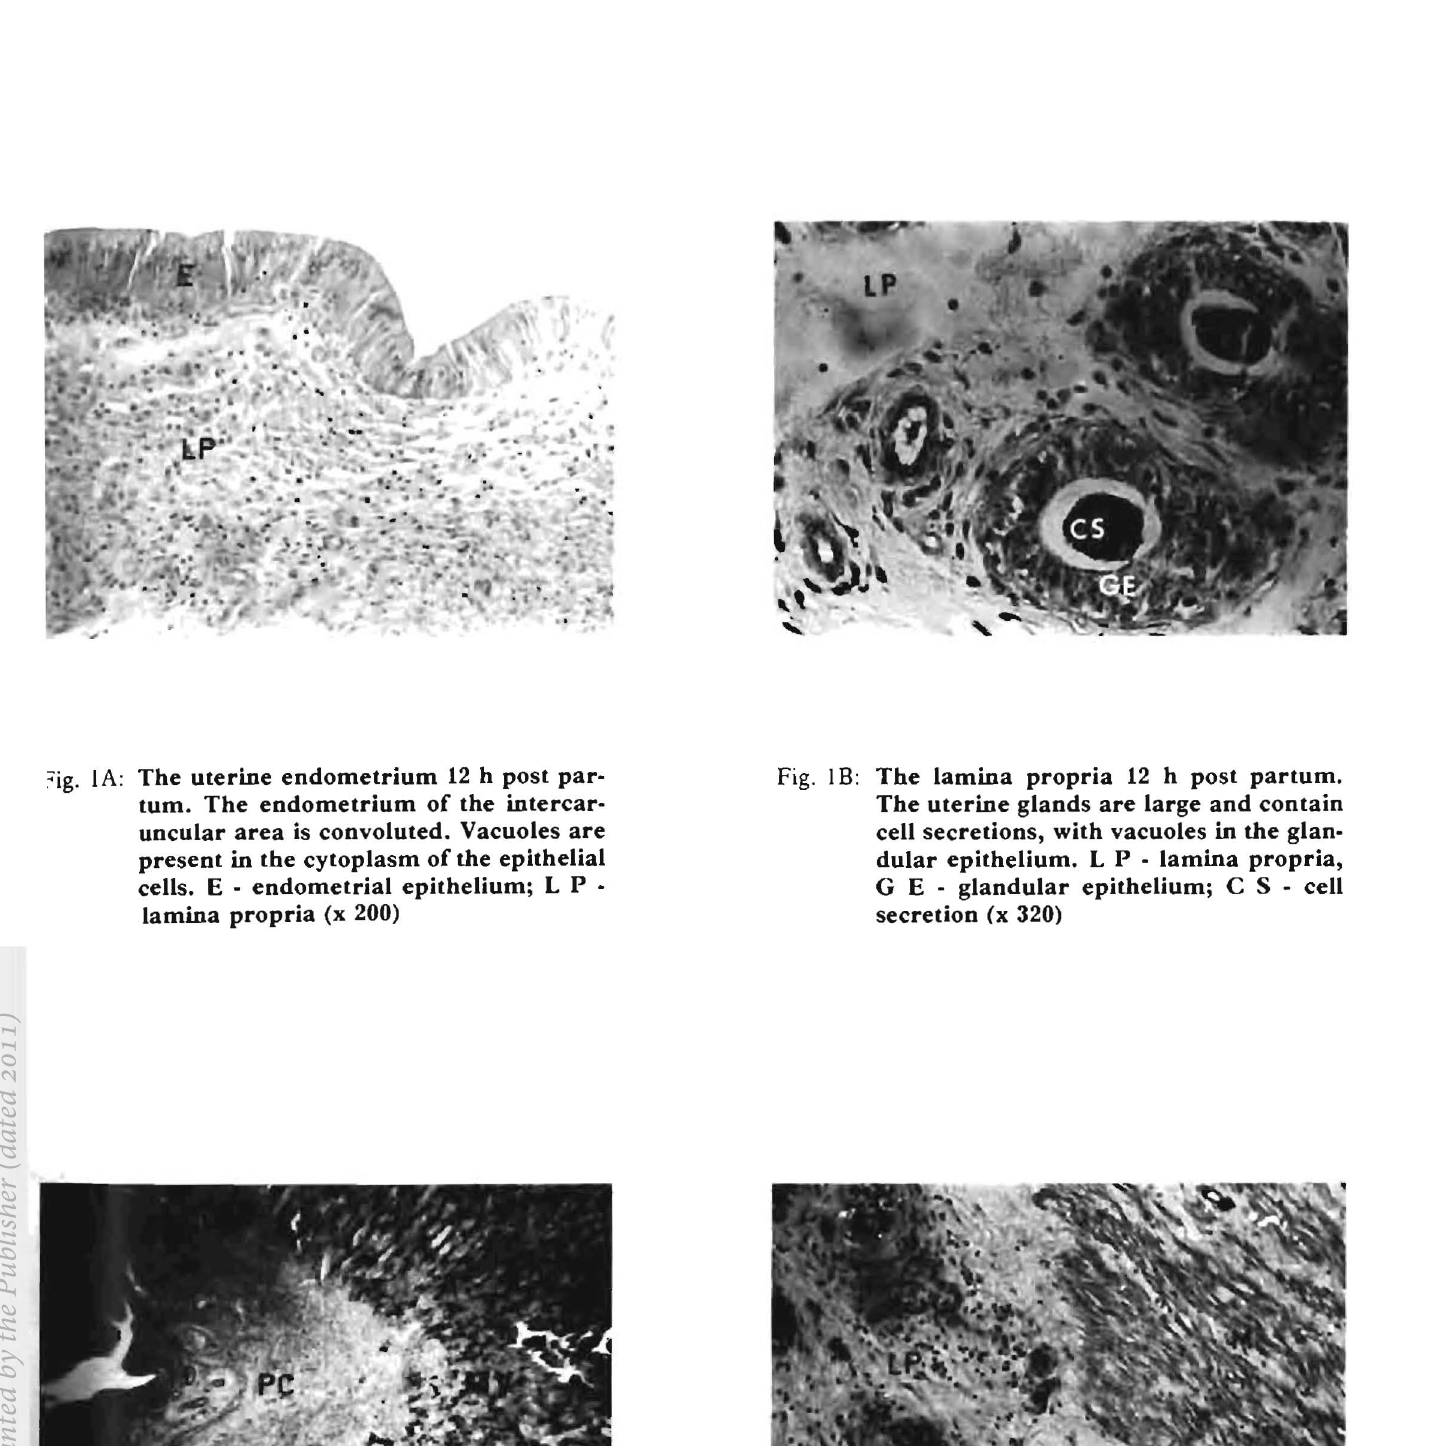
Fig. Ie: The caruncular area 4 d post partum. The permanent caruncular tissue is con tracted at the base of the maternal villi, which have degenerated. The proximal area of the maternal tissue is an amor phous mass of connective tissue. PC